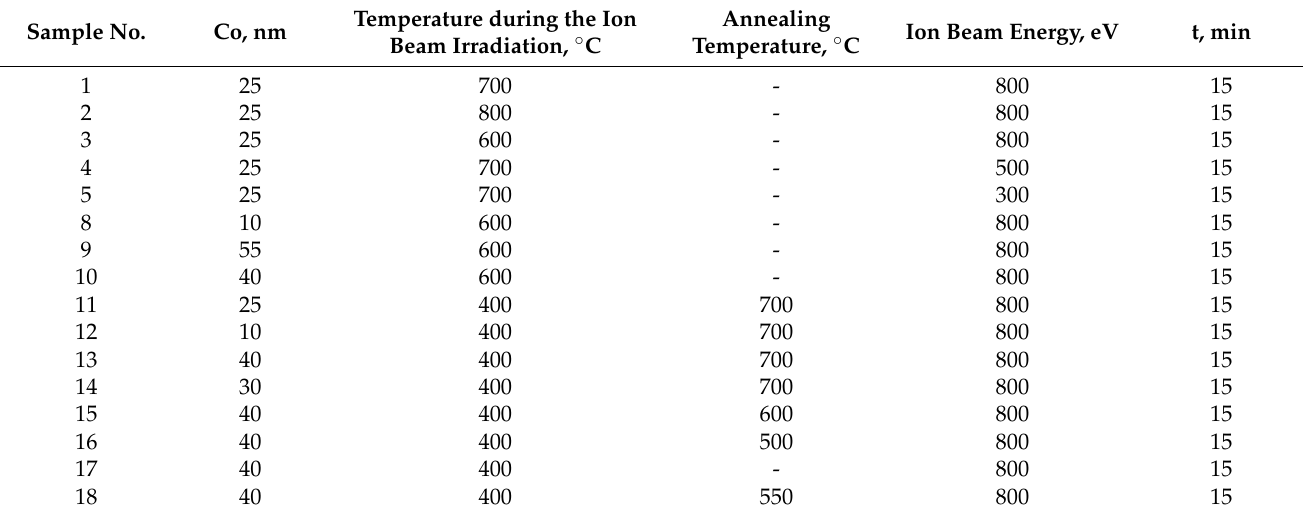
Table 1. Varied parameters of direct single and two-step graphene synthesis in the present